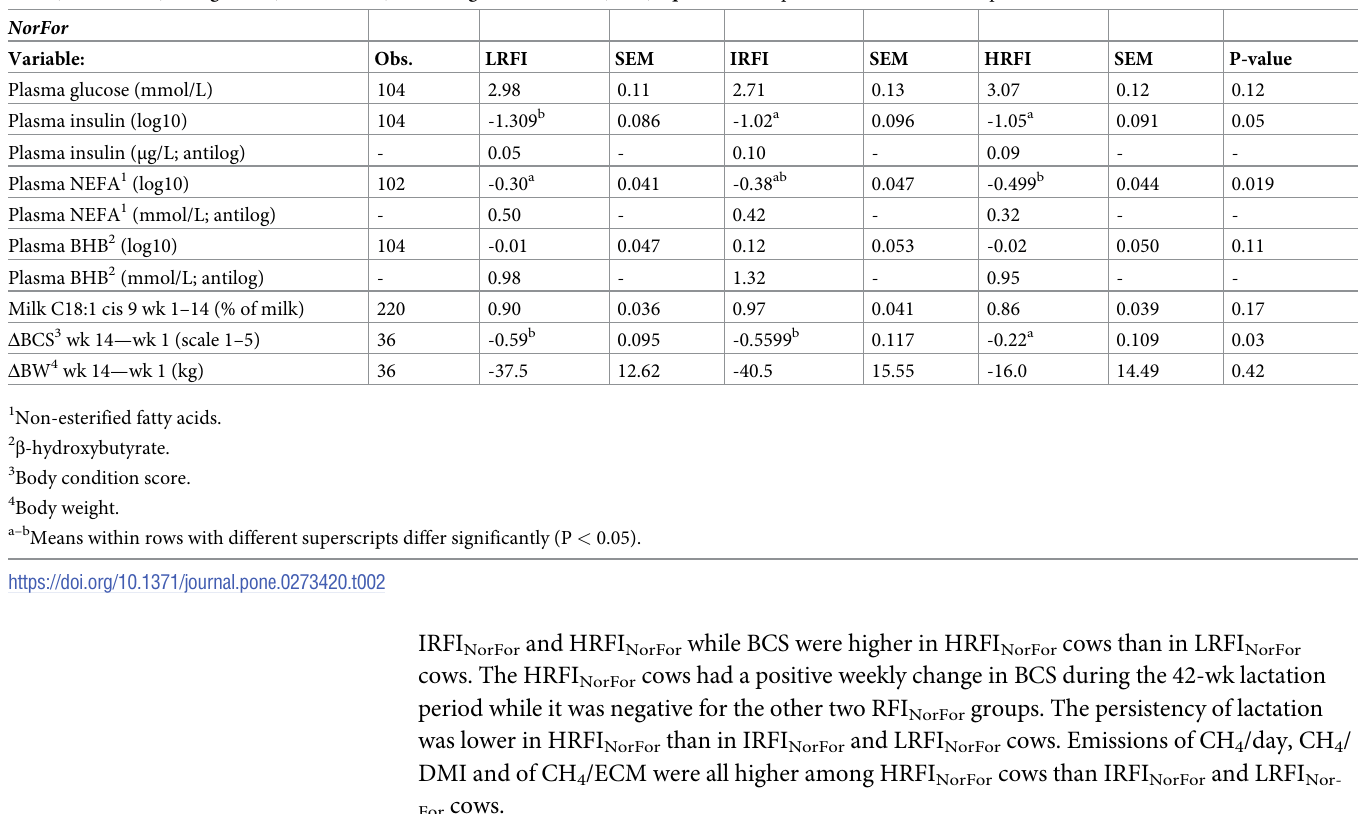
Table 2. Metabolic and related variables (mean and SEM) in cows in early lactation divided into three groups, with low residual feed intake (LRFI; n = 12), interme- diate (IRFI; n = 12) or high RFI (HRFI; n = 12) according to the NorFor (2011) equation. The plasma variables were sampled in lactation week 2, 4, and 6.